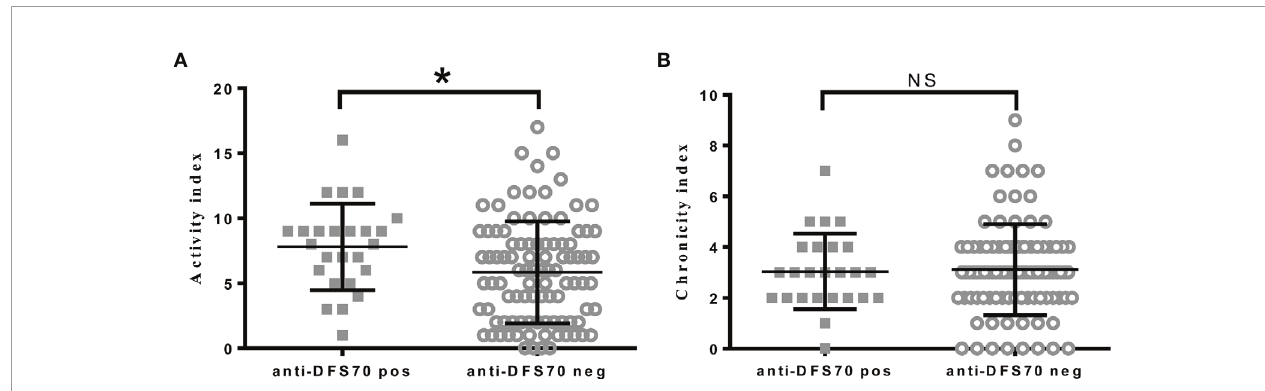
FIGURE 2 | Comparisons of pathological activity and chronicity index in LN patients with positive or negative anti-DFS70 antibodies. (A) Comparison of activity index in LN patients with positive or negative anti-DFS70 antibodies; (B) Comparison of chronicity index in LN patients with positive or negative anti-DFS70 antibodies. DFS70, dense fi ne speckles 70; LN, lupus nephritis; pos, positive; neg, negative. * P < 0.05; NS, no signi fi